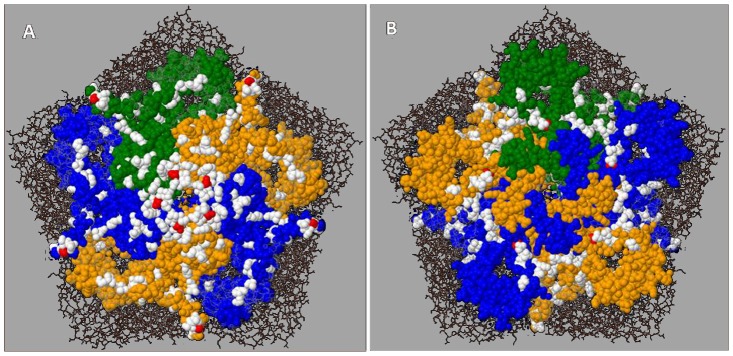
Locations of positively selected codons in 3-dimensional structure model of poliovirus capsid protein pentamer.For clarity, only VP1 is shown in space filling model with different colours in different protomers. Panel A, outside view; panel B, view from inside of capsid shell. Locations of variable amino acid sites are labelled with white colour and those showing evidence for positively selected codons (¤24, ¤144, and ¤221) with red.